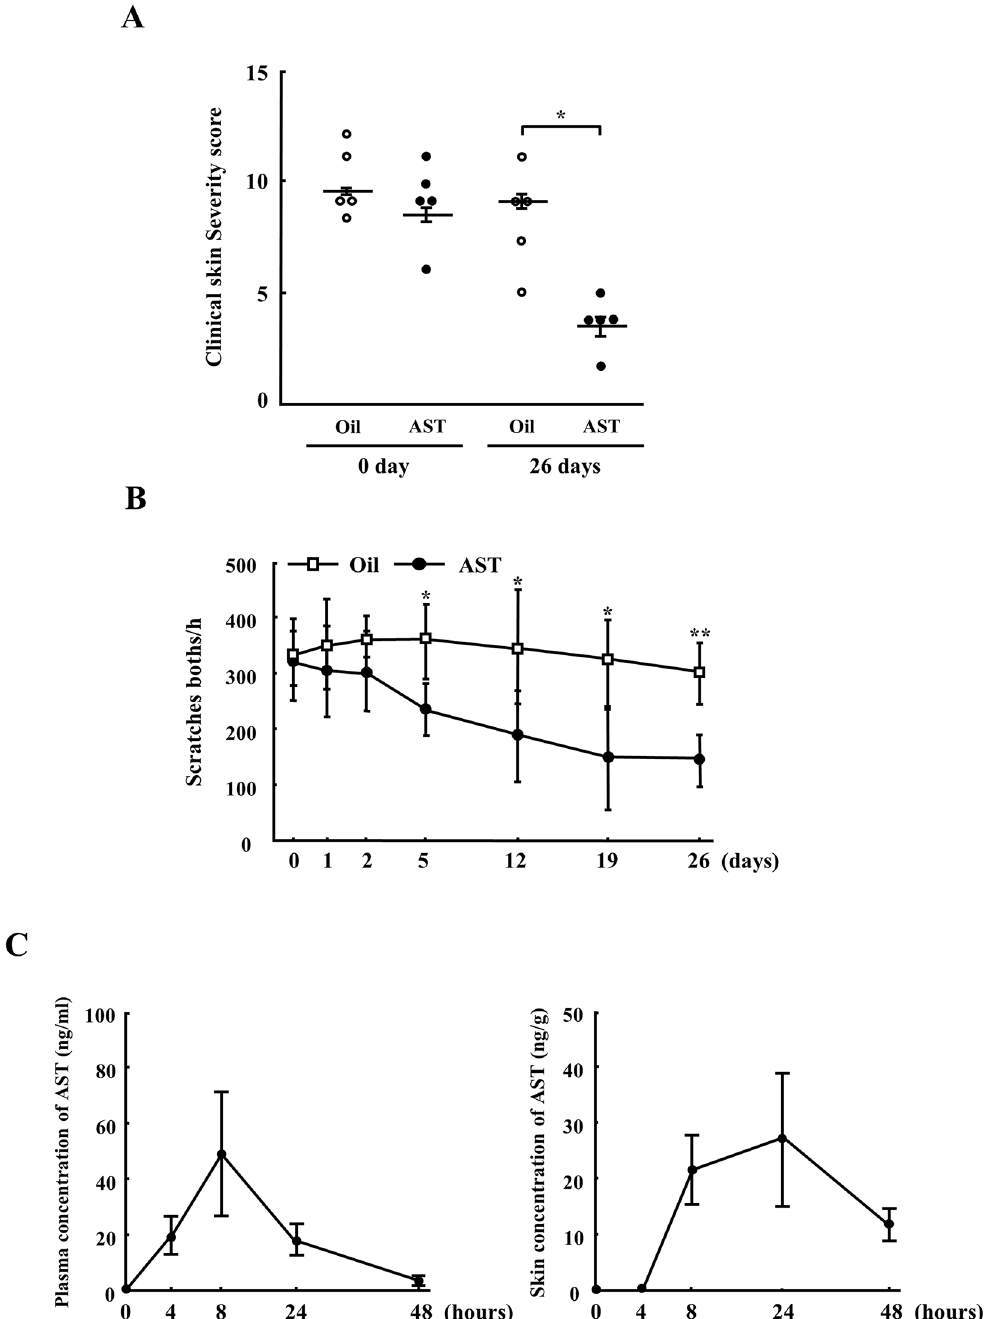
Fig 1. Effects of AST on the clinical severity and scratching behavior of dermatitis and the concentrations of AST in the NC/Nga mice. The clinical skin severity scores (A) and scratching behavior (B) of the NC/Nga mice after the oral administration of oil or AST (100 mg/kg) for 26 days. (C) The concentrations of AST in the NC/Nga mice after the oral administration of AST (100 mg/kg) for 48 hours. Changes in the concentrations of AST in the plasma and skin of the NC/Nga mice. The results are given as the mean ± SD for five mice in each group. * p < 0.01.